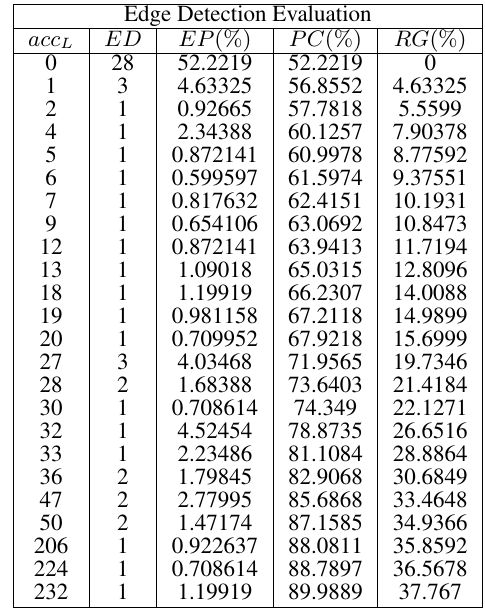
Table 1. Accumulator rate of detection and edge